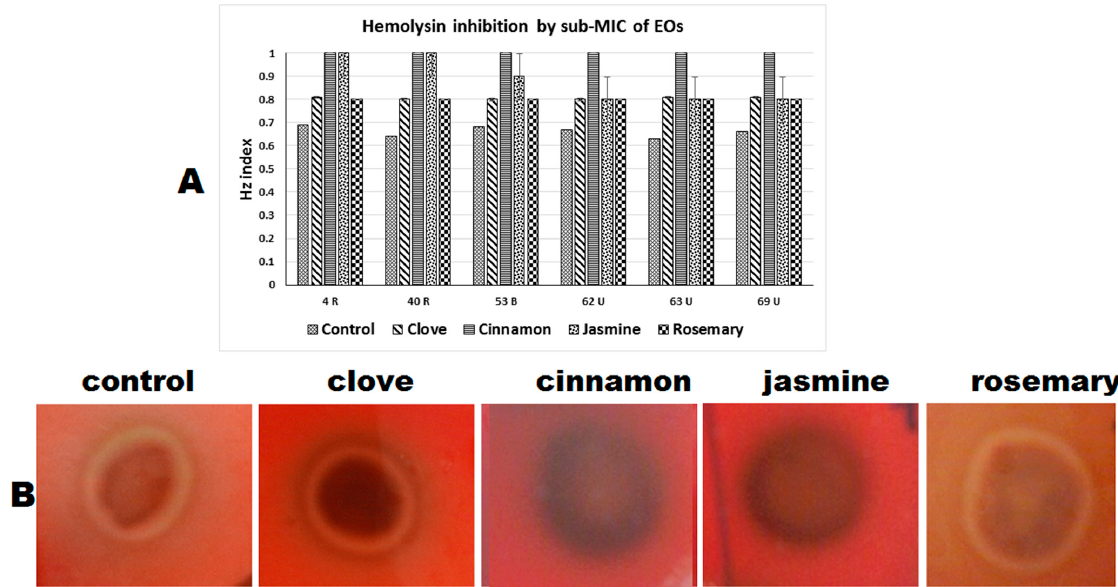
Figure 5. Hemolysin inhibition in C. albicans clinical isolates. ( A ) Graph showing changes in Hz value upon exposure to sub-MIC of different EOs (the smaller the Hz value the stronger the hemolysin activity and vice versa). ( B ) Representative images of hemolysin inhibition on Sabouraud dextrose-blood agar containing sub-MIC of EOs.